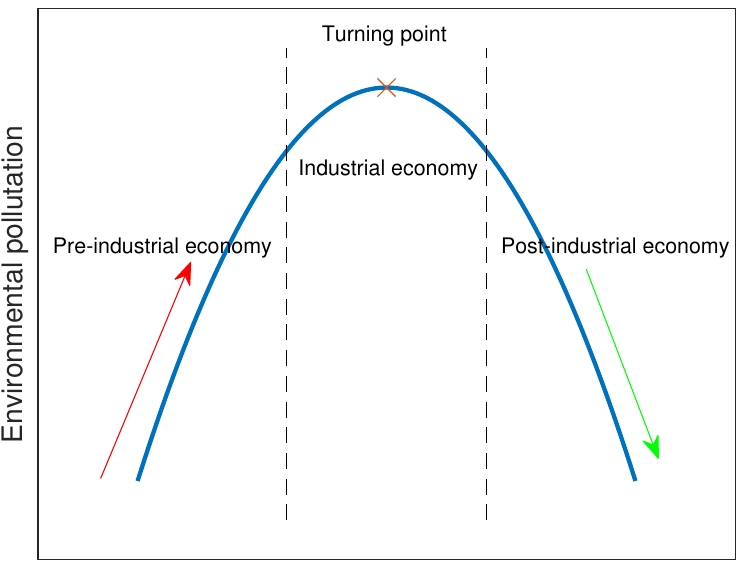
Figure 3. The theoretical inverted U-shaped Kuznets curve ( β 1 > 0, β 2 < 0, β 3 = 0). The function has three stages: pre-industrial, industrial, and post-industrial economies. If a country moves on the Kuznets curve in the direction of the red arrow, this implies a developing country with increasing income causing increasing environmental pollution. On the contrary, moving along the green arrow implies a developed country with increasing income but decreasing emissions because they have financial effort to take care of the environment. The turning point is marked by the red